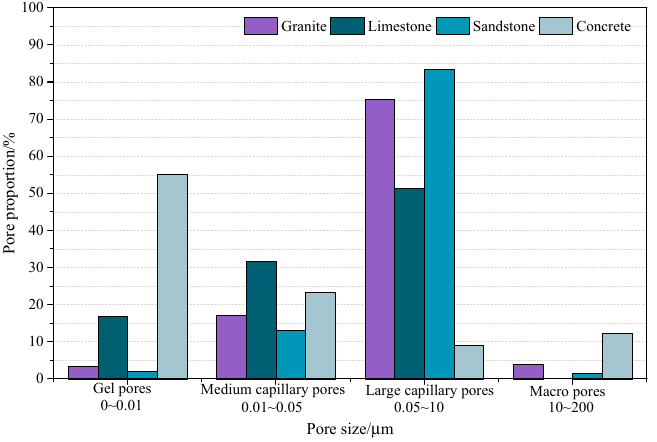
Figure 4. Mortar pore size proportion around rock and concrete.